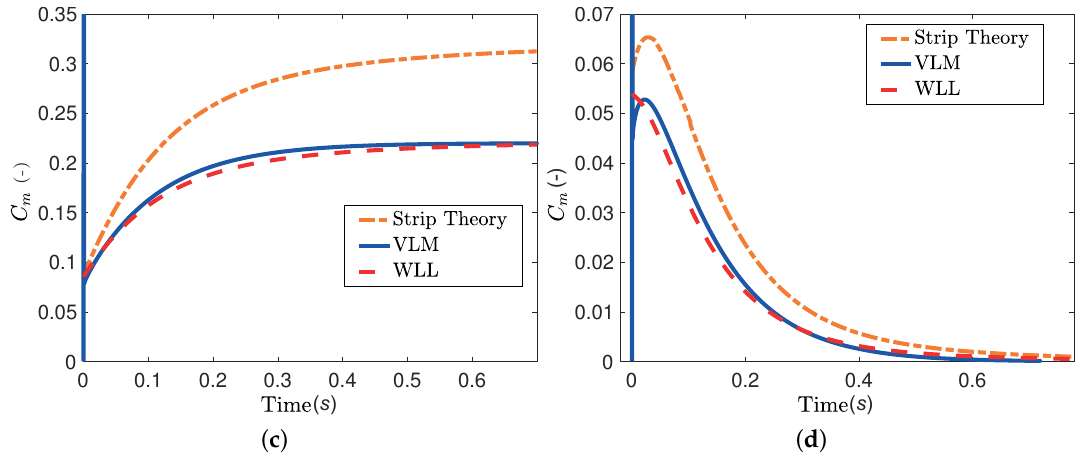
Figure 11. Comparison between VLM, WLL and strip theory for a tapered wing, AR = 6, undergoing a step motion. ( a ) Lift coefficient, pitch step A = 5 ◦ ; ( b ) Lift coefficient, plunge step A = 0.1 m; ( c ) Moment coefficient, pitch step A = 5 ◦ ; ( d ) Moment coefficient, plunge step A = 0.1 m.